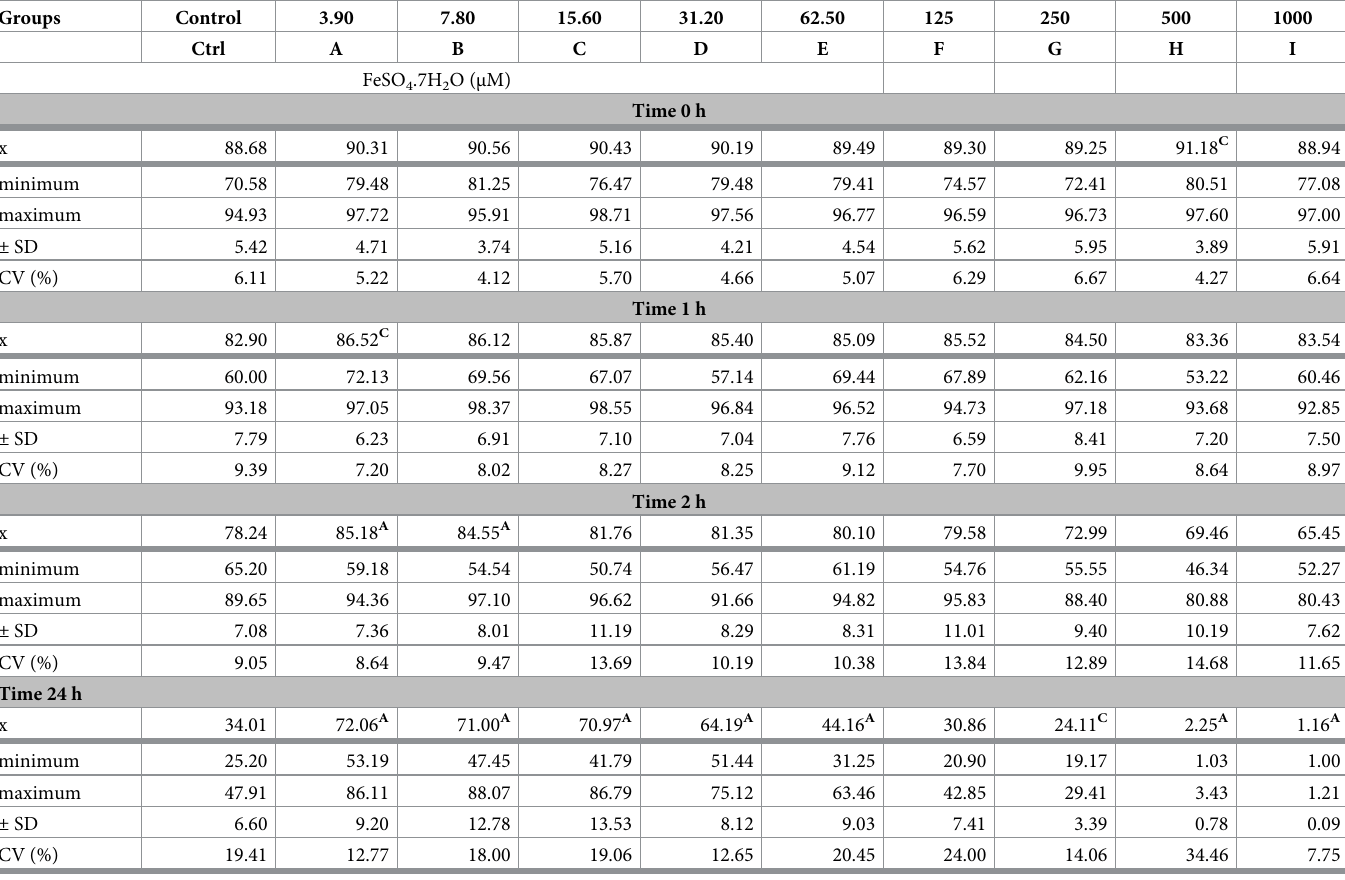
Table 2. Progressive spermatozoa motility (%) exposed to FeSO 4 .7H 2 O in different time